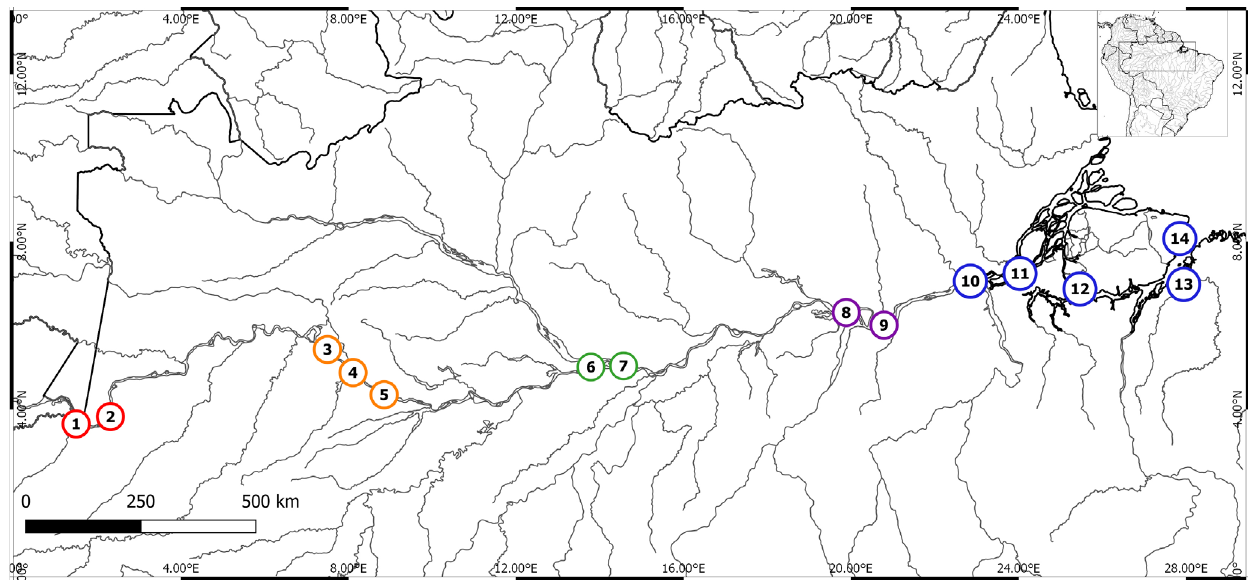
FIGURE 1 | Sampling sites for Brachyplatystoma vaillantii along the Solimões-Amazonas River axis. The localities were grouped in five fishing landing towns as follow: Red circles: Tabatinga (1 – Benjamin Constant, 2 – Tabatinga), Orange circles: Tefé (3 – Mucura Lake, 4 – Tefé, 5 – Vila Nova), Green circles: Manaus (6 – Manaus, 7 – Careiro da Várzea), Purple circles: Santarém (8 – Santarém, 9 – Tapará) and Blues circles: Estuary (10 – Almeirim, 11 – Gurupá, 12 – Breves, 13 – Belém, 14 –